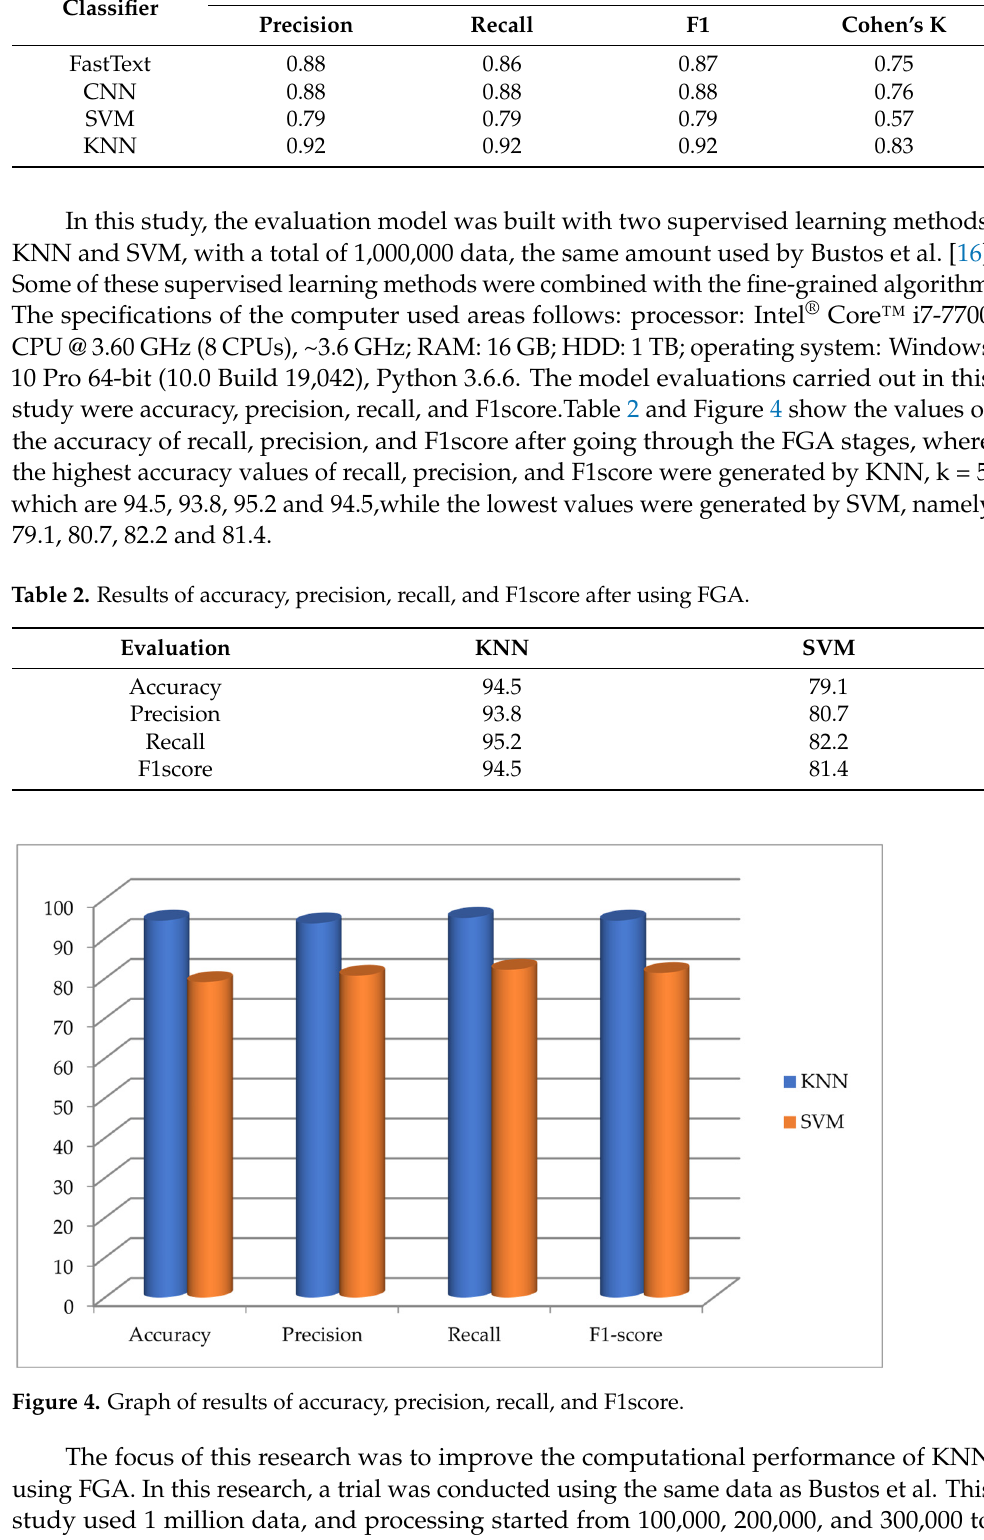
Table 1. Overall results of the validation set for all classifiers using a dataset of 10 6 samples.